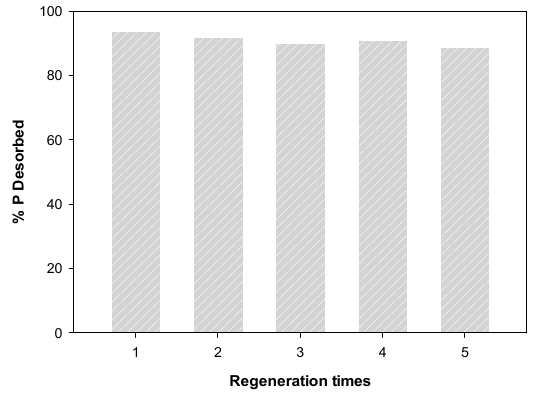
Figure 12. Regeneration of WBC12.